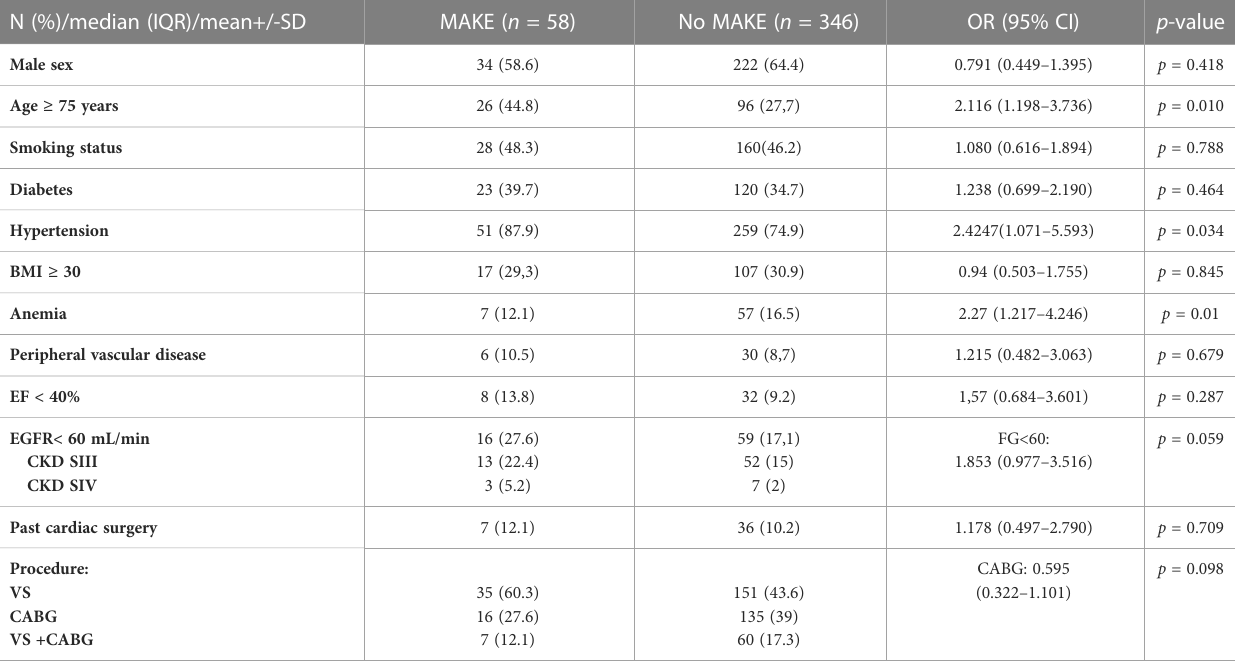
TABLE 4 Univariate analysis of baseline risk factors for 1-year MAKE.